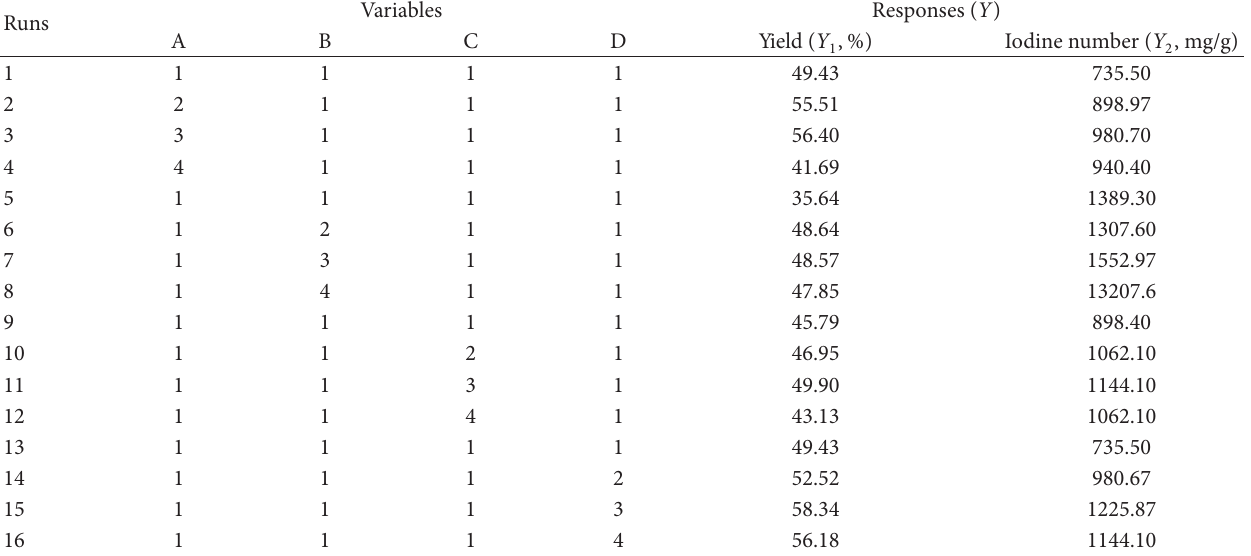
T 2: Experimental design matrix and